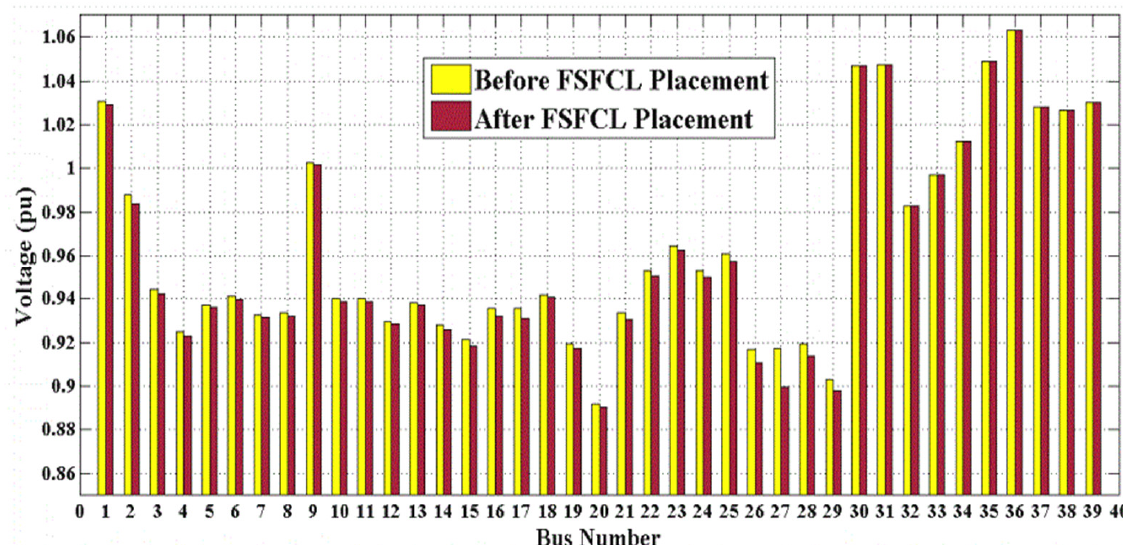
Figure 14. Voltage profile of New England system.